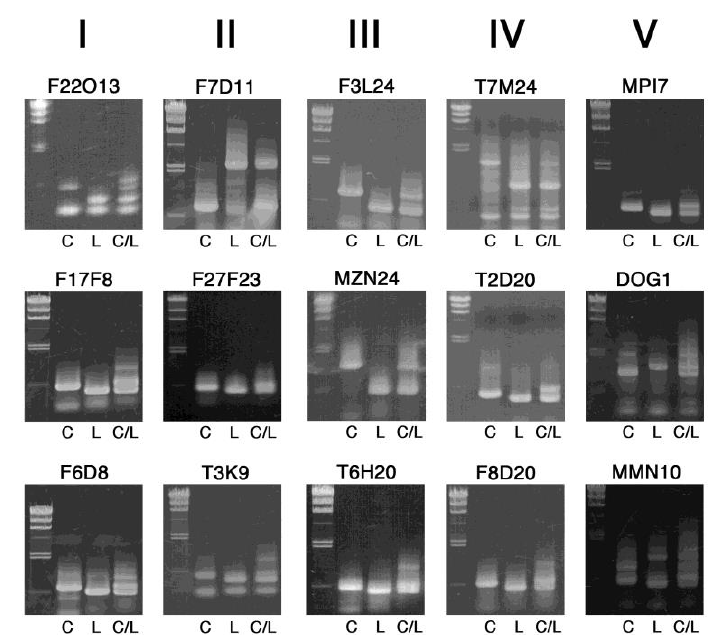
Figure 2. Band patterns of InDel markers useful for initial rough mapping. PCR-amplified DNA fragments were electrophoresed on 0.8% agarose gels, together with size markers of lambda DNA digested with Hin dIII (23.1, 9.4, 6.6, 4.4, 2.3, 2.0 and 0.56 kb) on the left side. C, L and C / L indicate template DNA from Col-0, L er -0 and their F1 heterozygous progeny, respectively. The chromosome number is shown on the top.